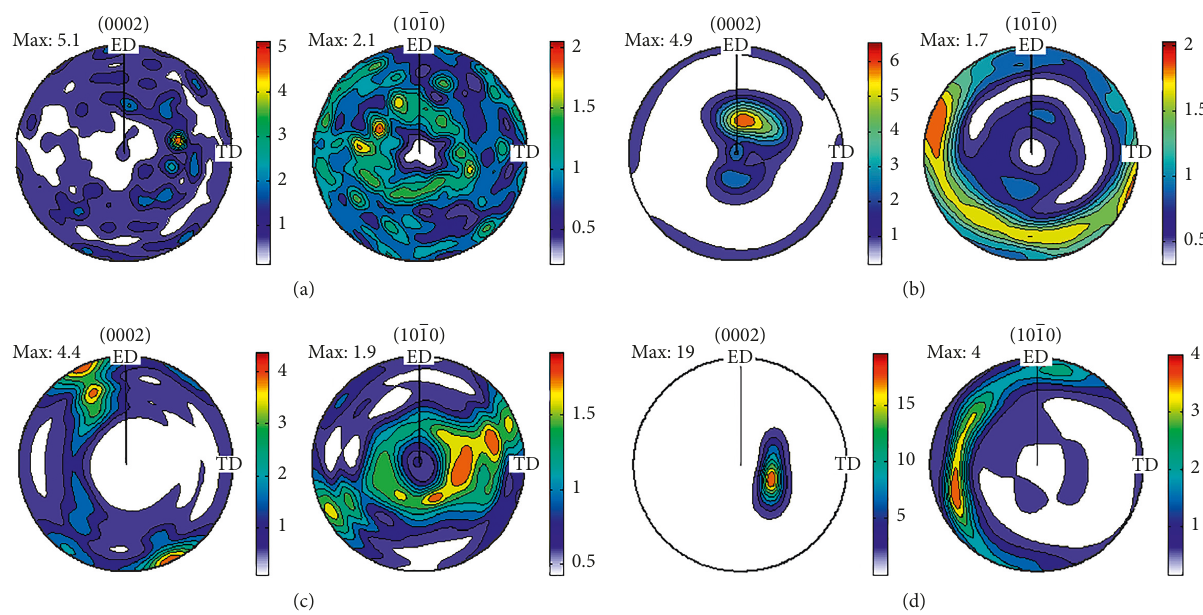
Figure 11: (0002) and (10–10) pole figures of the studied Mg alloy after CEE process: (a) as-annealed; (b) one-pass; (c) two-pass; (d) three-pass.